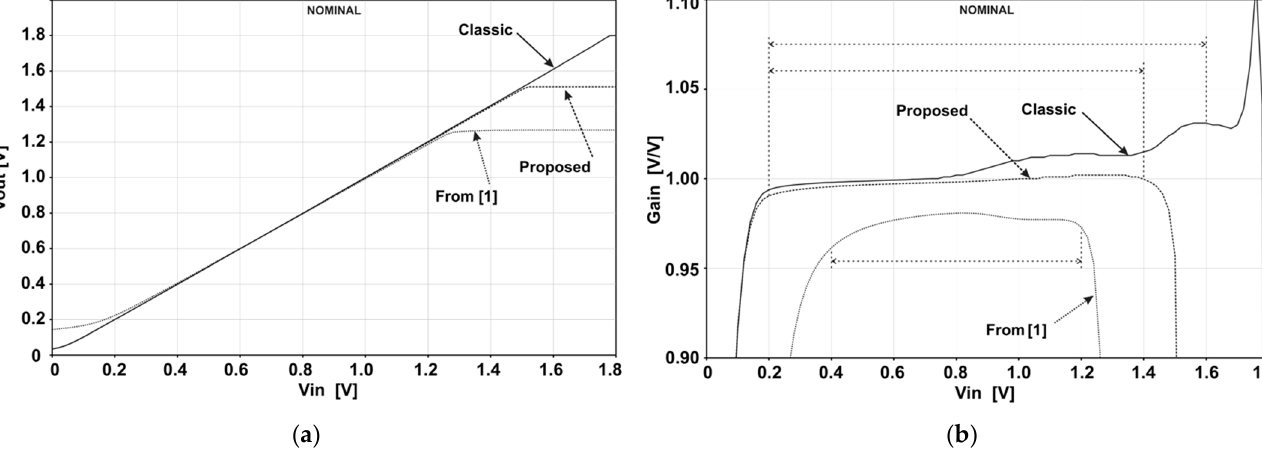
Figure 4. Simulated static characteristics: ( a ) V out vs. V in ; ( b ) Gain = d V out /d V in . Nominal (corner) models of transistors are used.